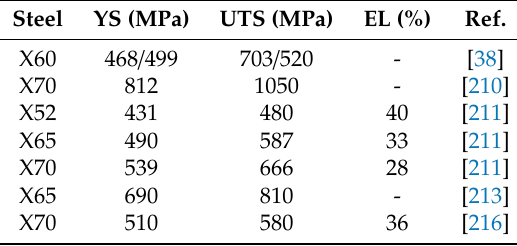
Table 9. Reviewed mechanical properties for internal corrosion studies.